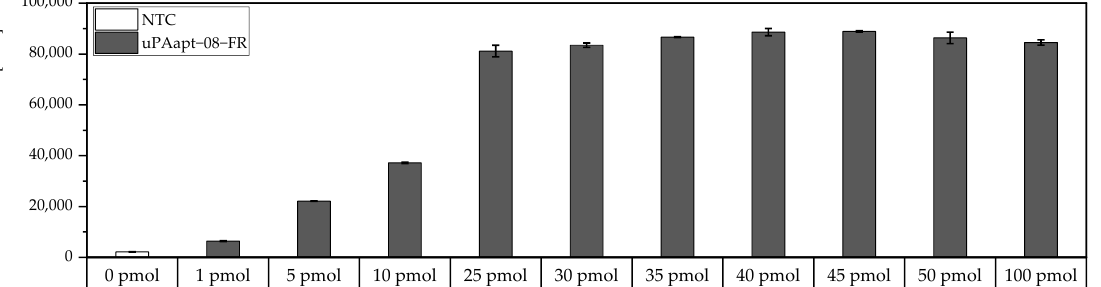
Figure 2. Binding of different amounts of 5′ - biotinylated uPAapt−08−FR to the wells of the Pierce™ streptavidin coated high-capacity 96-well micro titer plate by a modified FLAA. Different amounts of uPAapt−08−FR were incubated in different concentrations (0 pmol – 100 pmol in 100 µL BPs-T) to the wells to determine the maximum binding capacity for the smallest aptamer. After washing of the wells, followed by incubation with Invitrogen™ Quant - iT™ OLIGREEN™, a fluorescence signal of the immobilized aptamer could be measured. The relative fluorescence unit [RFU] for each sample is shown as the mean value of technical replicates and was measured using the multimode microplate reader Mithras 2 LB 943. Error bars represent the range of measured values. NTC = No Target Control (0 pmol). Number of records n = 2.